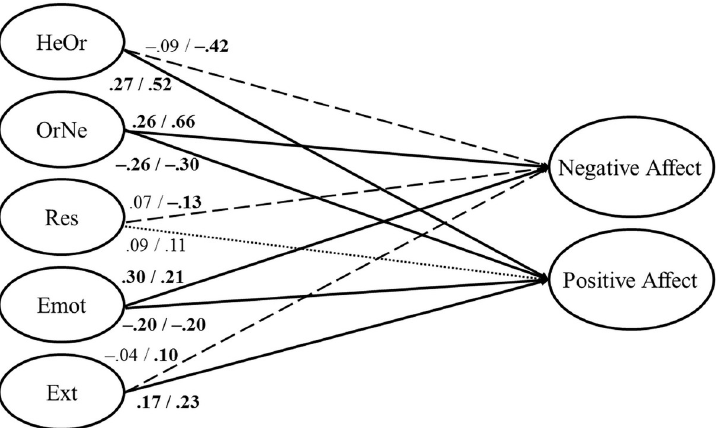
Fig 1. Structural model of the relationships between the five different eating styles and positive and negative affect. Solid arrows correspond to statistically significant ( p < .05) coefficients in both samples; dashed arrows correspond to statistically significant coefficients in just one of the two samples; dotted arrows correspond to non- statistically significant coefficients in both samples. Bold values correspond to statistically significant coefficients. HeOr = Healthy Orthorexia; OrNe = Orthorexia Nervosa; Res = Restrained Eating; Emot = Emotional Eating; Ext = External Eating.